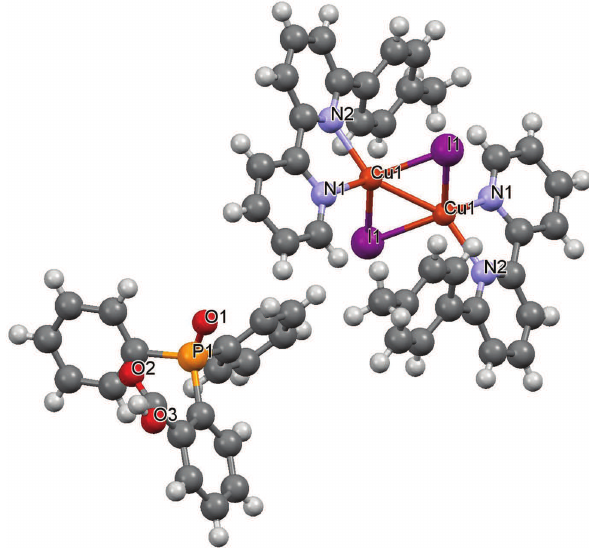
Table 1: Data collection and